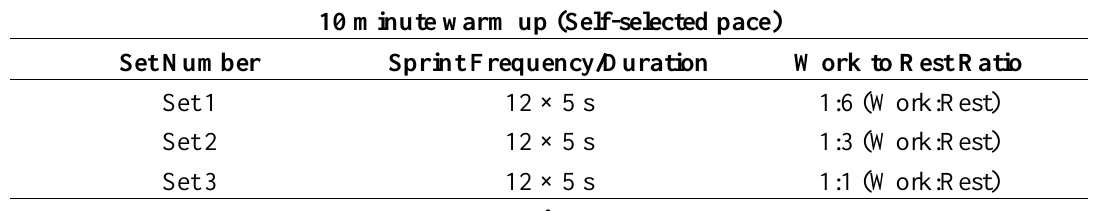
Table 1. Simulated road cycling race protocol (Vaile et al. , 2008) [29]. Work—Maximal effort sprint. Rest—Power at 40%–50% W W . TT (Time Trial)—Sustained maximal max